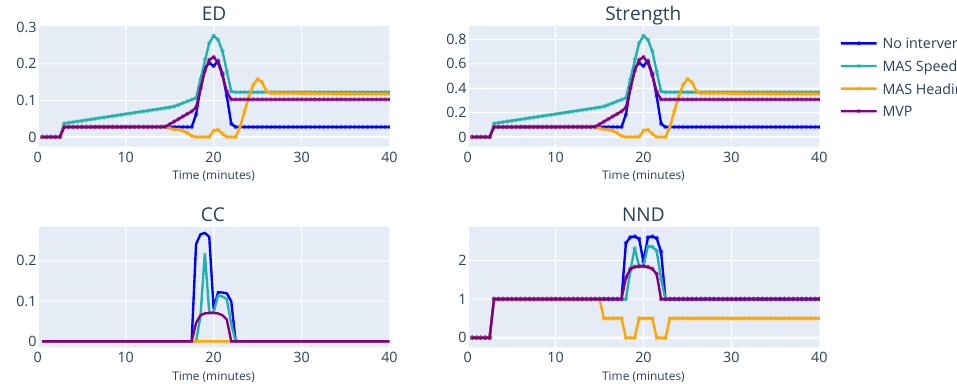
Figure 11. Miles-in-Trail with 2 aircraft per flow.